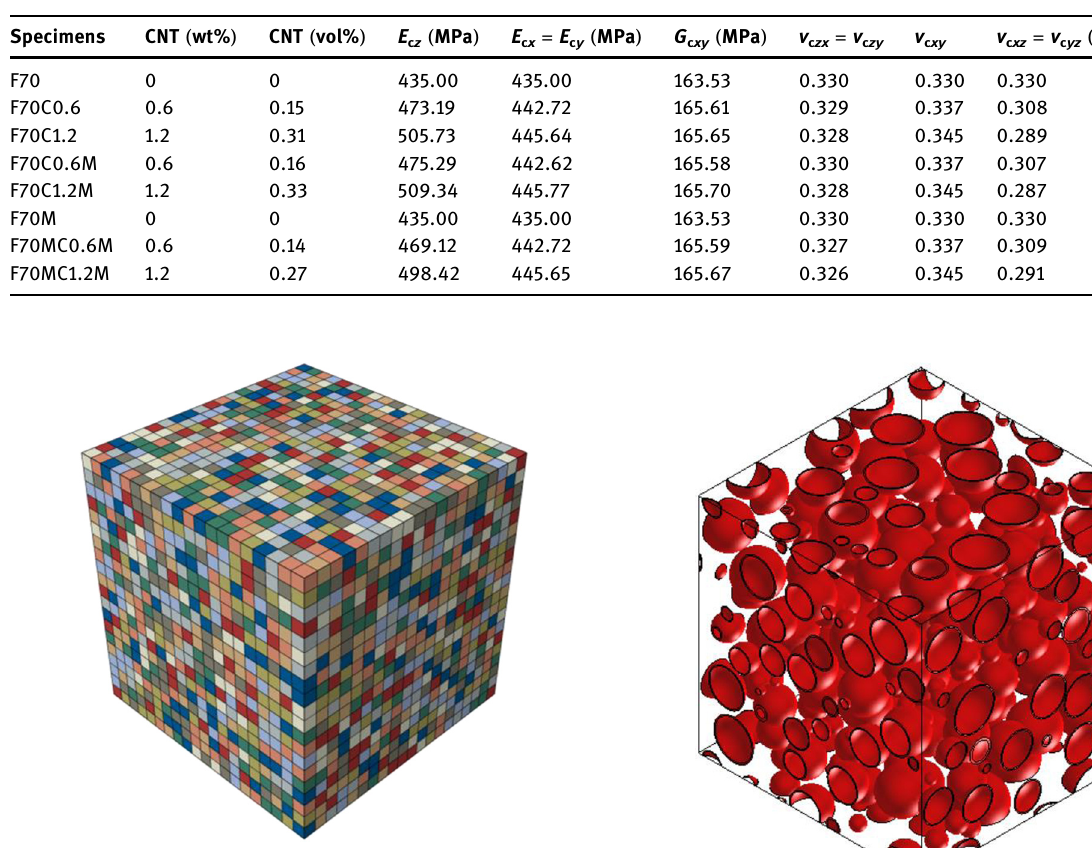
Table 5: Material properties of short CNT RVEs extracted from FE model